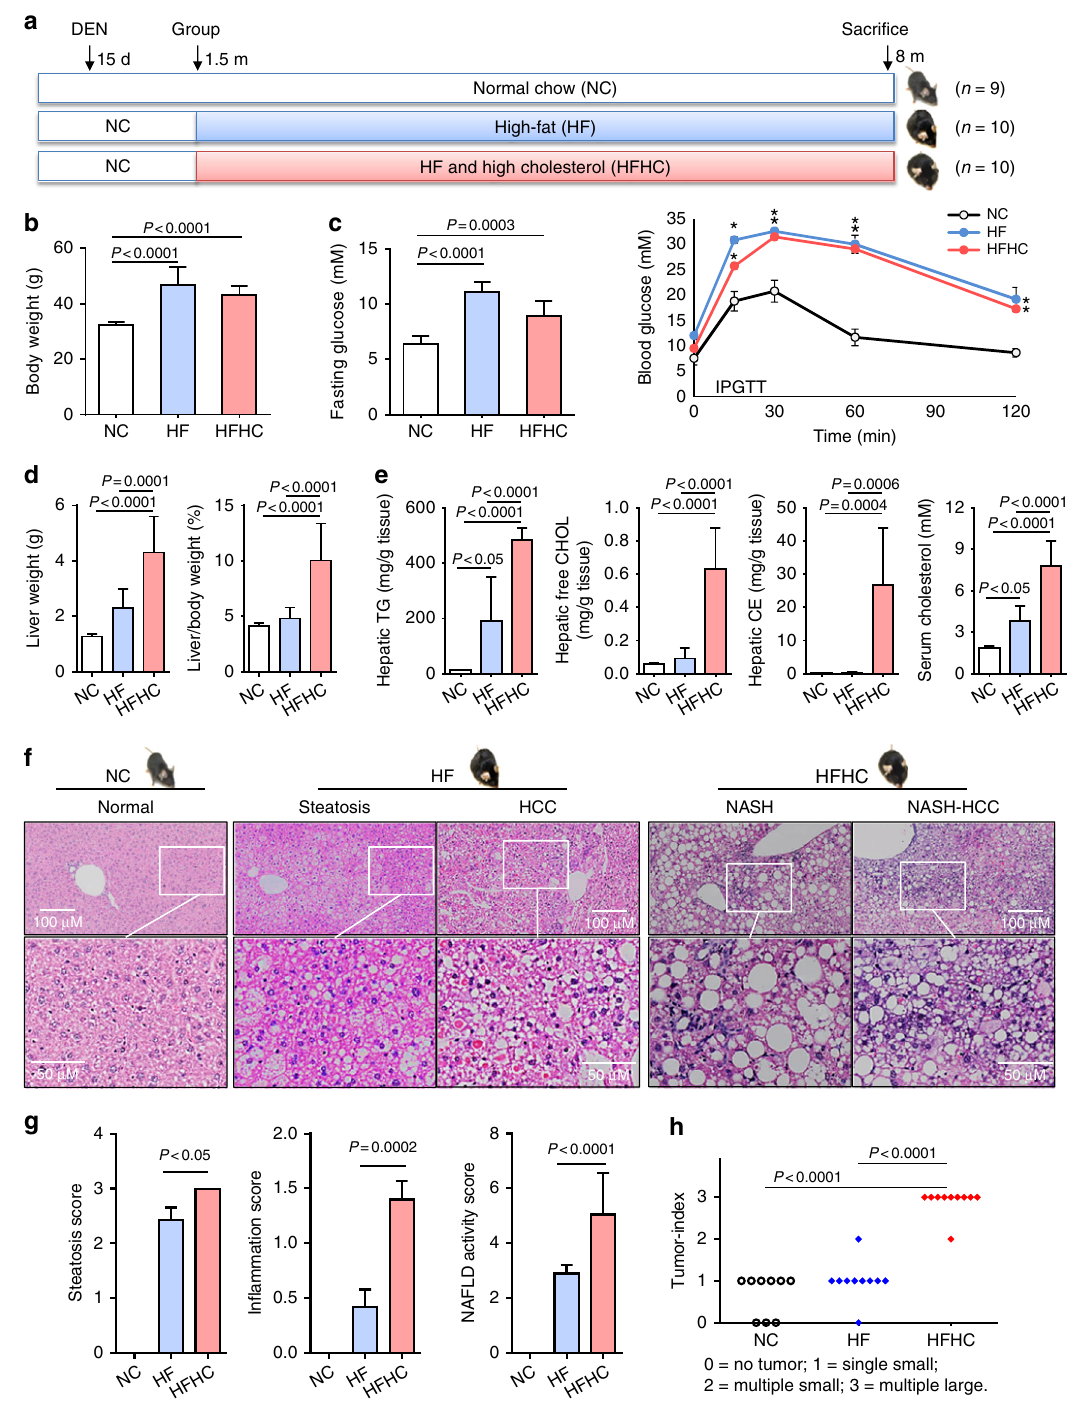
Fig. 1 Cholesterol augmented high-fat (HF) diet in accelerating hepatocarcinogenesis in mice. a Schematic illustration of the treatment of mice. Male C57BL/6J mice were administered a single injection of the carcinogen diethylnitrosamine (DEN) intraperitoneally at age 15 days and fed normal chow ( n = 9), HF ( n = 10) or high-fat high-cholesterol (HFHC; n = 10) diets starting from 6 weeks of age till 8 months. b Body weights of mice fed HF or HFHC diets were similar and both signi fi cantly higher than normal chow (NC)-fed mice. c Fasting blood glucose and intraperitoneal glucose tolerance test (IPGTT) levels in mice fed NC, HF or HFHC diets. * P < 0.05. d Mice fed HFHC diet had signi fi cantly higher liver weights and liver-body weight ratios than HF-fed Representative H&E staining histological images ( f ) and NAFLD scores ( g ) of liver tissues from HF- and HFHC-fed mice. h HCC incidence, number and size in NC-, HF- and HFHC-fed mice after DEN injection. Tumor number: few < 5; multiple ≥ 5. Tumor size: small, all < 5 mm 3 ; large, at least one ≥ 5 mm 3 . The data are shown as means ± SE for IPGTT and means± SD for others. Data in b-g between each two groups were compared using ANOVA Tukey ’ s